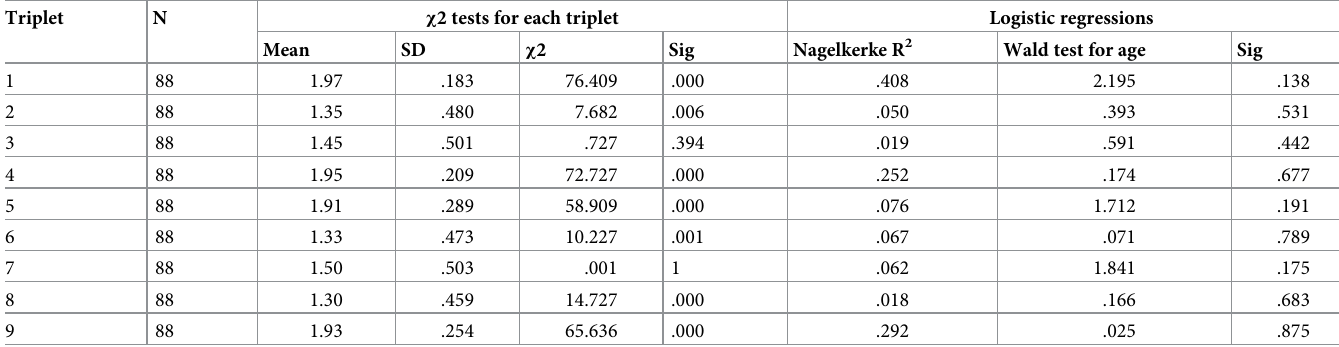
Table 5. Chi-square and logistic regression tests for each